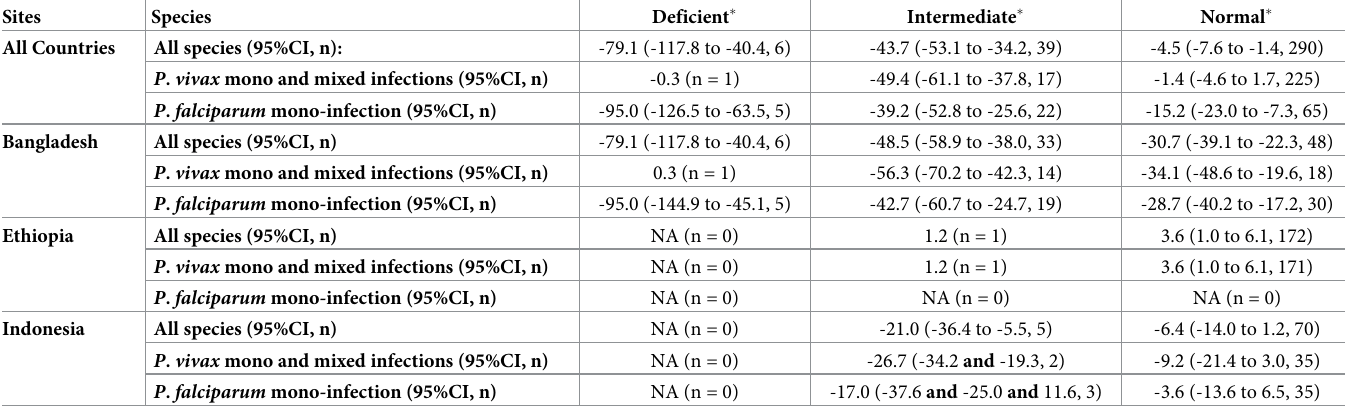
Table 2. Percentage Change (95% Confidence Intervals) in G6PD activity between acute malaria and follow up.